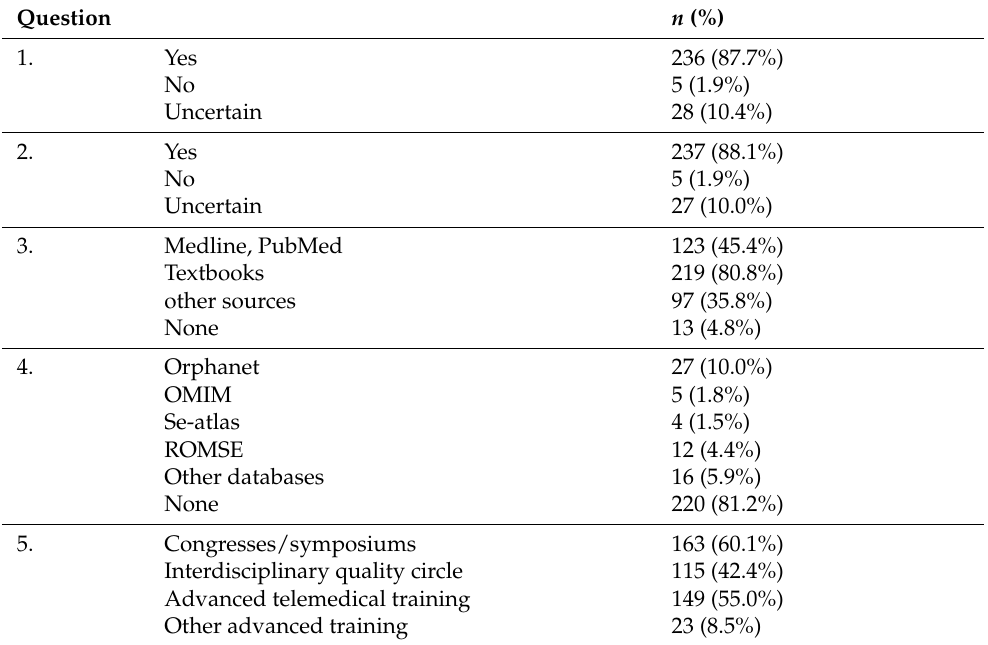
Table 4. Questions on the use of a register for rare diseases with an orofacial manifestation (Section